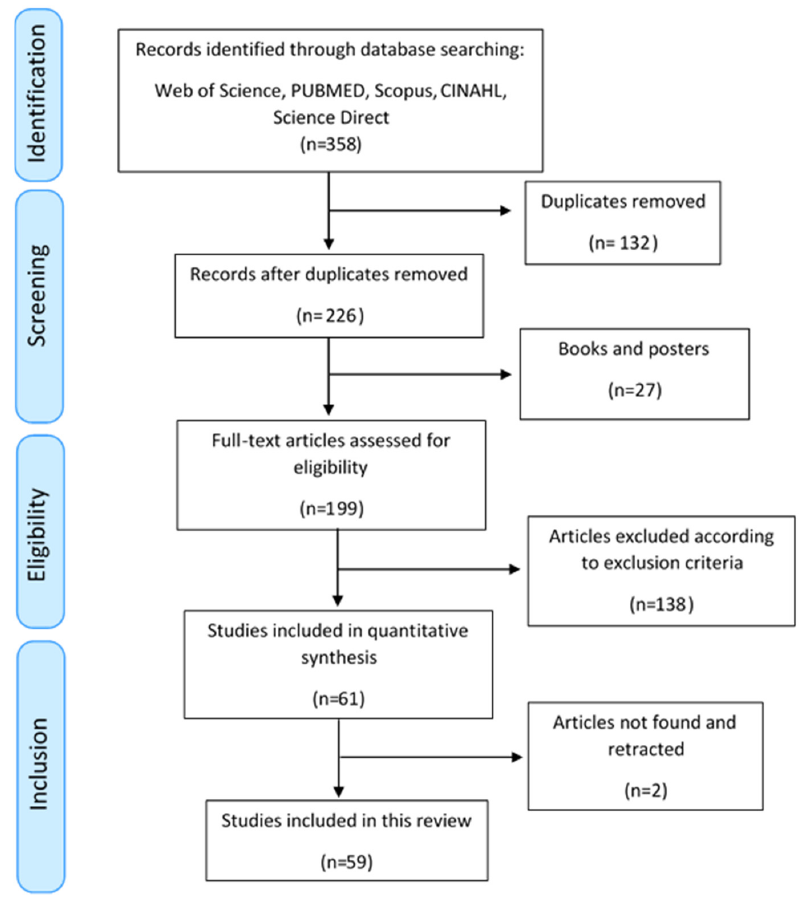
Figure 1. PRISMA diagram of the bibliographic review conducted.